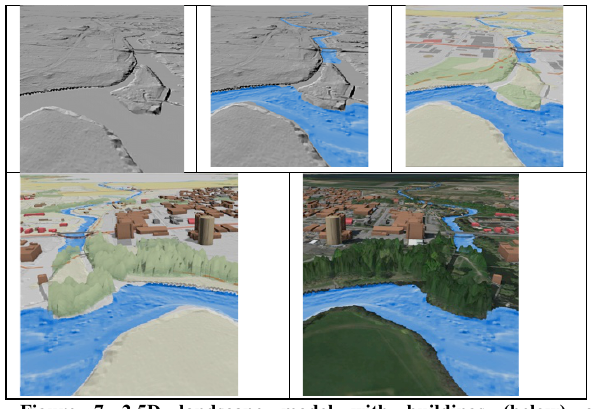
Figure 7 2.5D landscape model with buildings (below) of